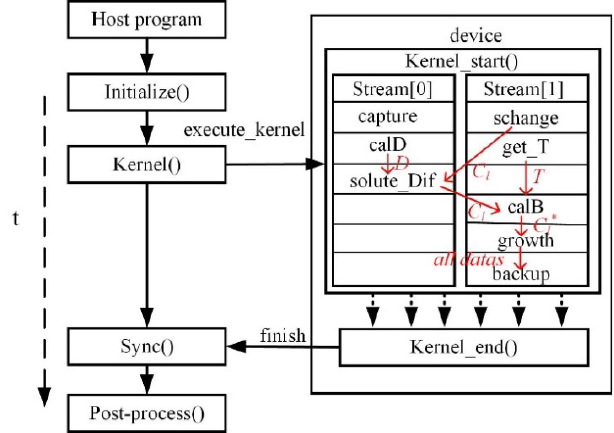
Figure 3. The flow-chart of the program model.